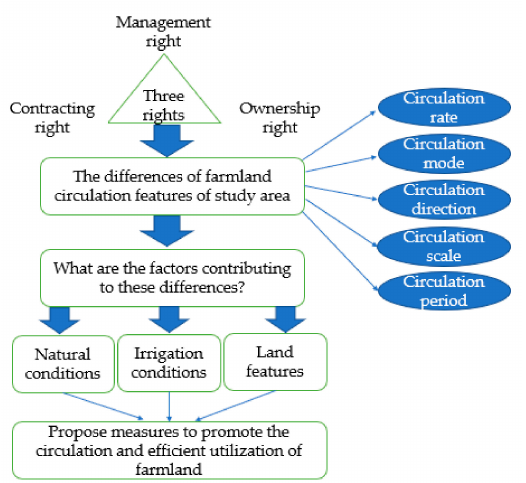
Figure 2. The analytical framework for farmland